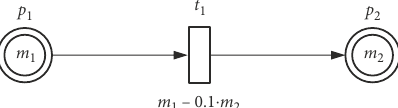
Figure 6. Simple continuous Petri